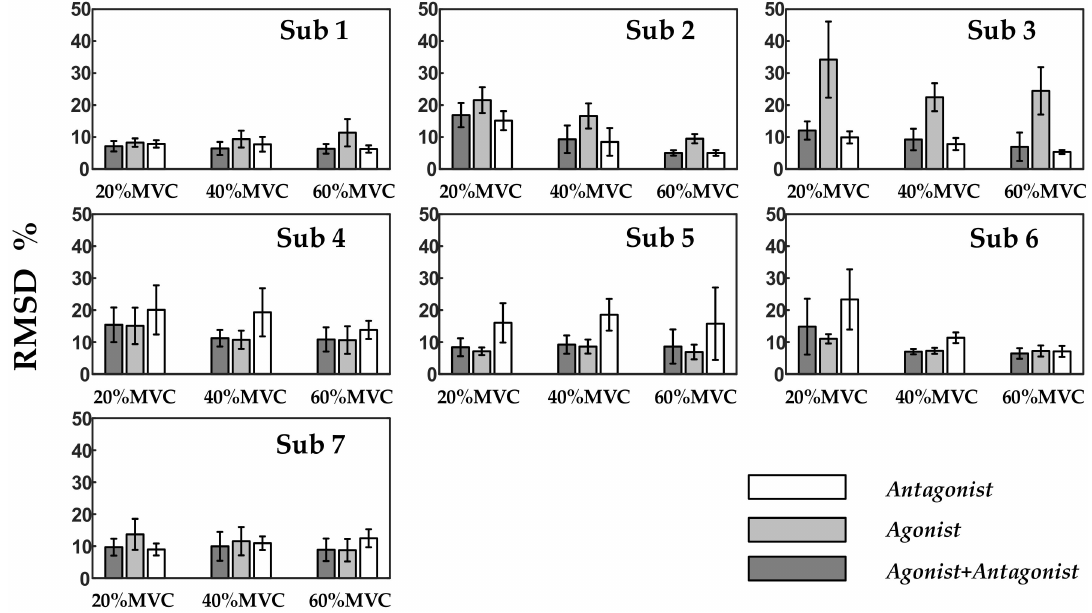
Figure 8. Force estimation results corresponding to the agonist, the antagonist, and both of them,